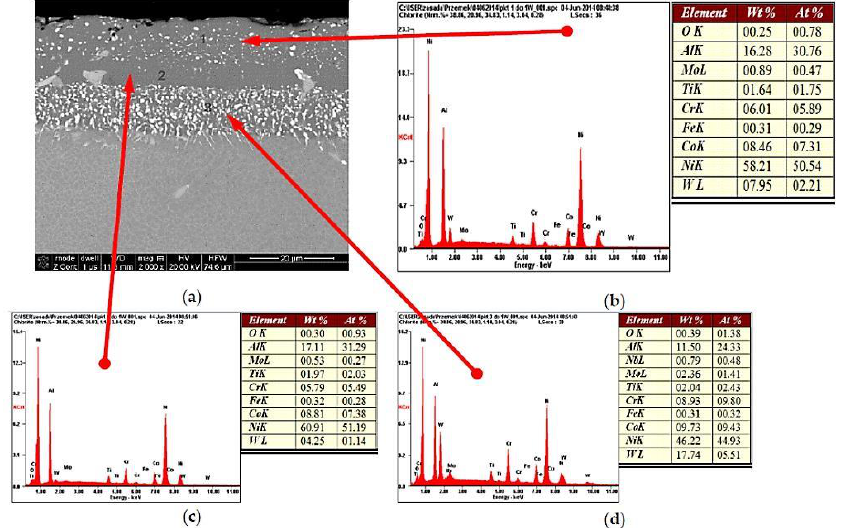
Figure 12. Three-layer barrier nickel aluminides (NiAl), with the coating diffusively applied to the TWC blade material ( a ), and the results of the microanalysis of the chemical composition in individual areas ( b – d ).